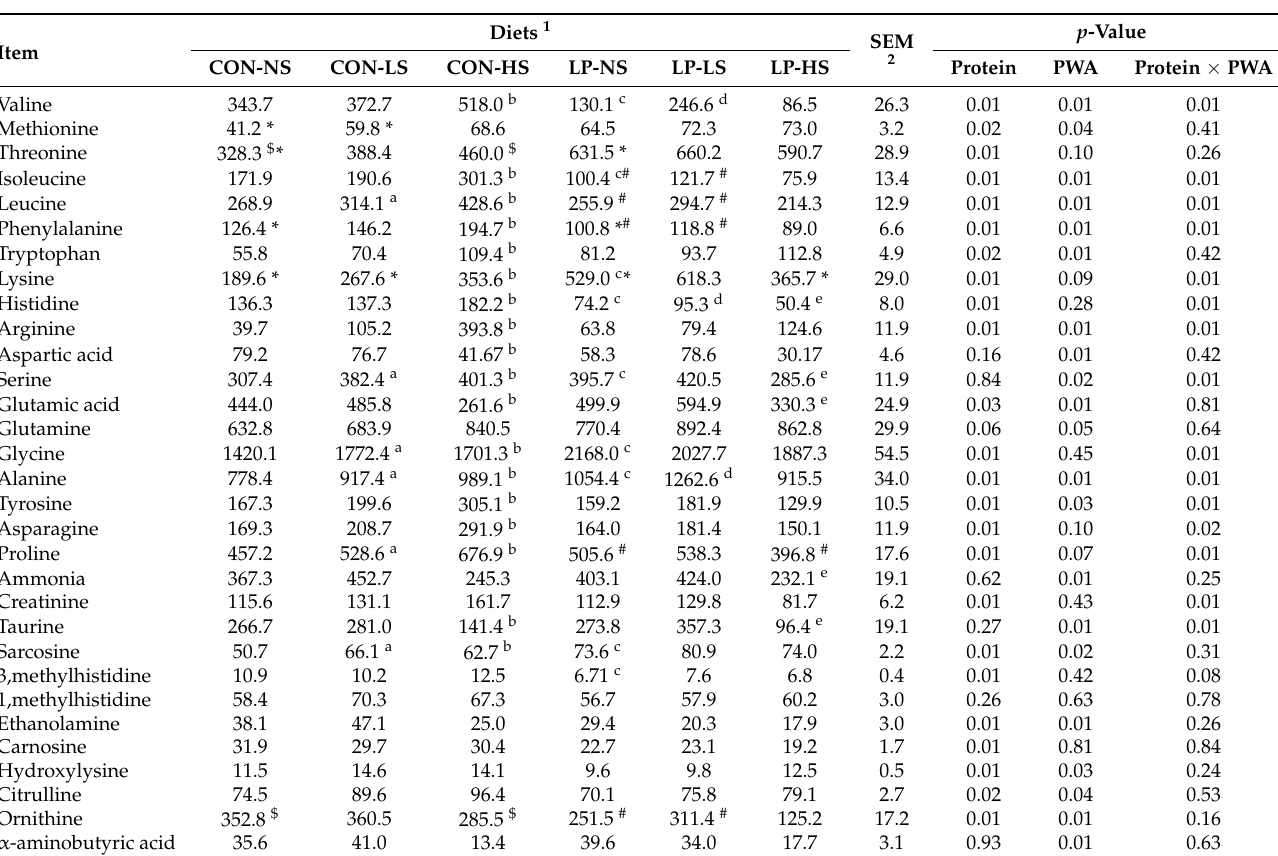
Table 5. The concentration (nmol/mL) of plasma nitrogen-containing compounds of nursery pigs fed with two levels of dietary protein and three levels of a phytogenic water